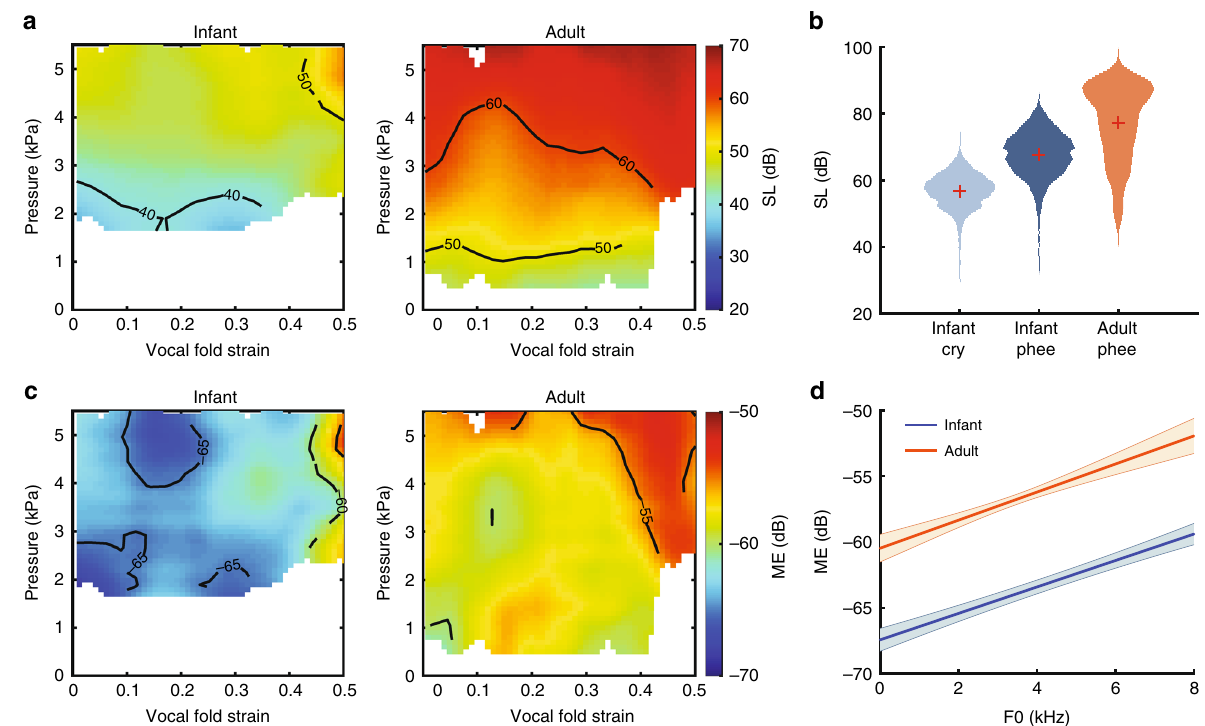
Fig. 4 Adult larynx is more energy ef fi cient than infant larynx. a Mean source level (SL) maps of infant ( n = 3) and adult ( n = 4) larynges. b Comparison of SL between marmoset infant cry ( n = 2524 utterances from 10 infants), infant phee ( n = 3301 utterances from 10 infants), and adult phee ( n = 433 utterances from 9 adults). Red crosses indicate mean. c Mean mechanical ef fi ciency (ME) of infant and adult larynges. d Linear regression of mechanical ef fi ciency vs. f o . Shaded areas indicate the 95% con fi dence interval. Source data are provided as a Source Data fi